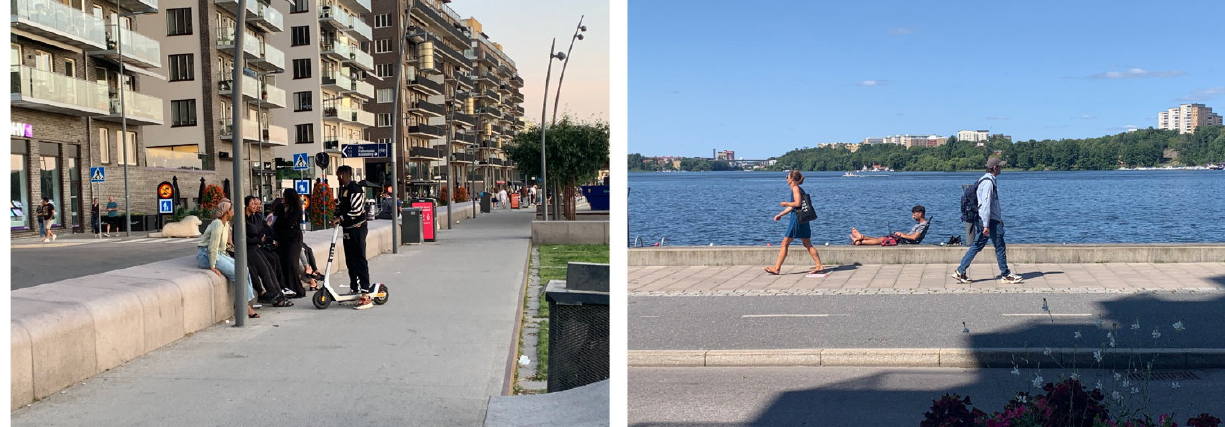
Figure 2. Street furniture (permanent): On the left, people sit and lean towards the street furniture placed in between the bike lane and the walking passage, and, on the right, people sit on the waterfront deck beside the pedestrian lane. life. Taking the summer season of the year 2021 as